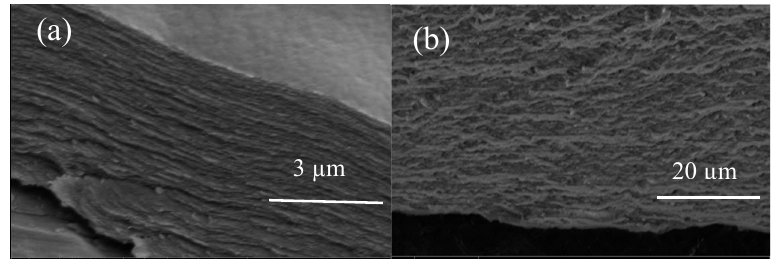
Figure 14. SEM images of ( a ) Laponite and ( b ) Laponite/ CA-pdms-fu.